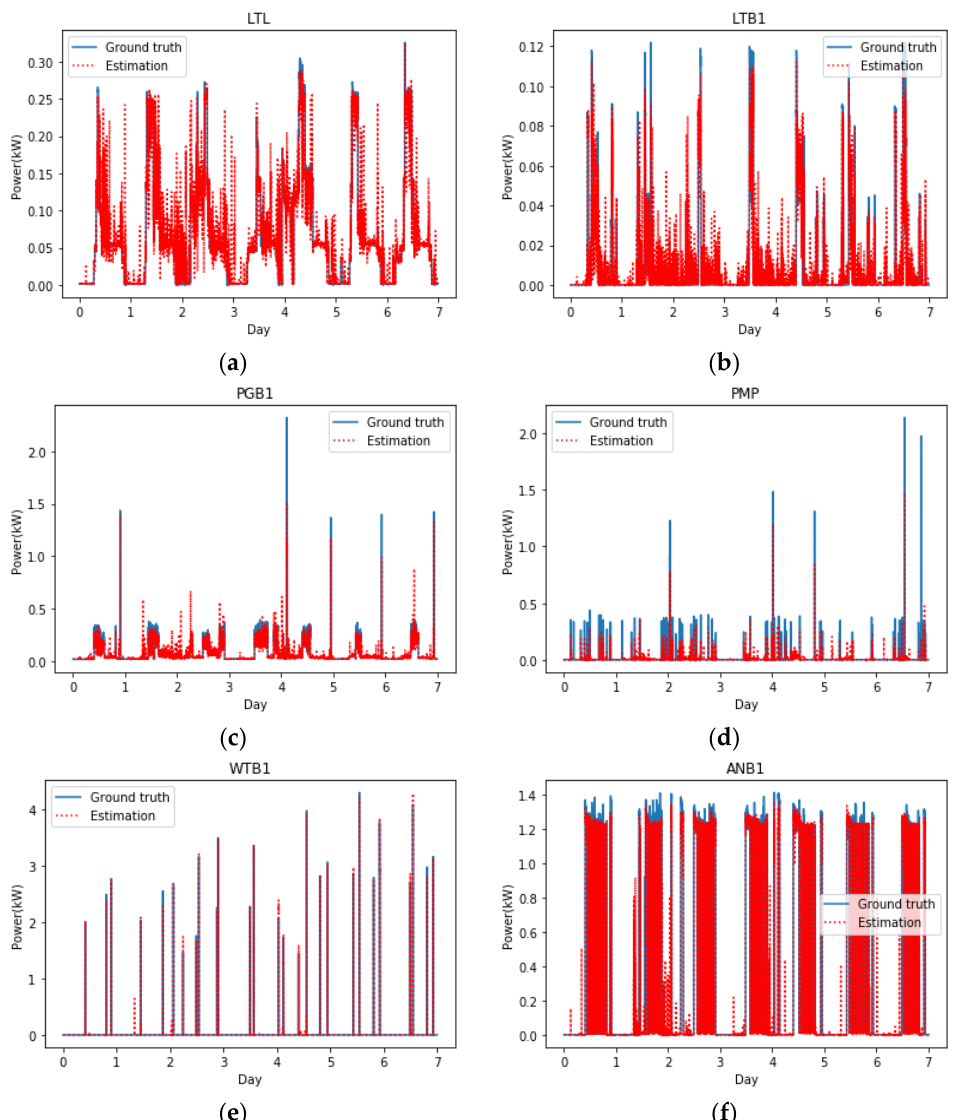
Figure 4. Power data plots of the ground truth and the estimation by the MTR model ( a ) LTL; ( b ) LTB1; ( c ) PGB1; ( d ) PMP; ( e ) WTB1; and ( f ) ANB1. ( b ) LTB1; ( c ) PGB1; ( d ) PMP; ( e ) WTB1; and ( f )